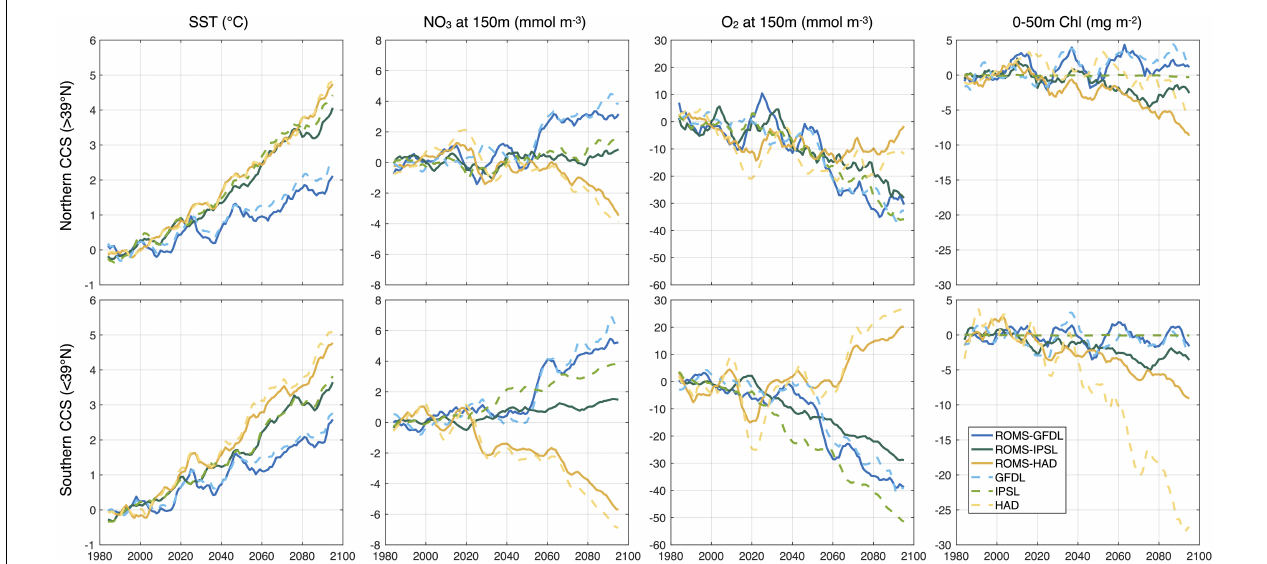
FIGURE 9 | From left to right time series of yearly averaged anomalies with respect to the historical period averaged from the coast to 100 km offshore of SST, NO 3 and O